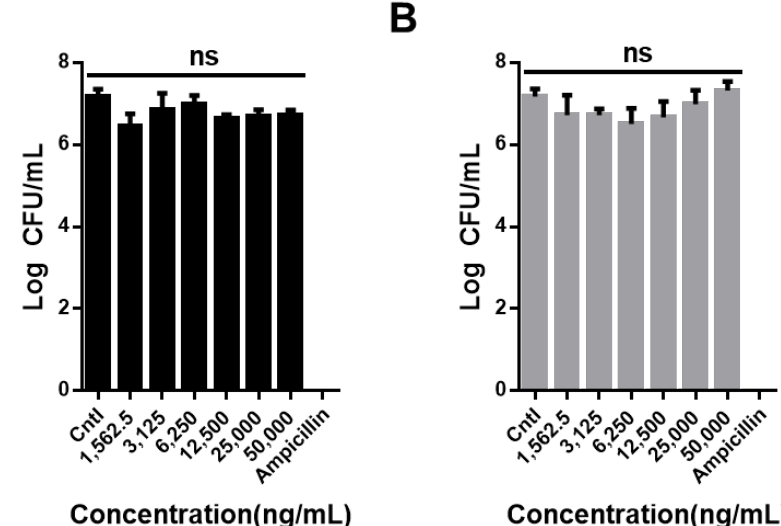
Figure 4. In vitro bacteria viability test of ( A ) CNO (black bar) and ( B ) CNO–COOH (gray bar) with varying concentrations (1562.5, 3125, 6250, 12,500, 25,000, and 50,000 ng/mL) using colony counting assay against Escherichia coli.